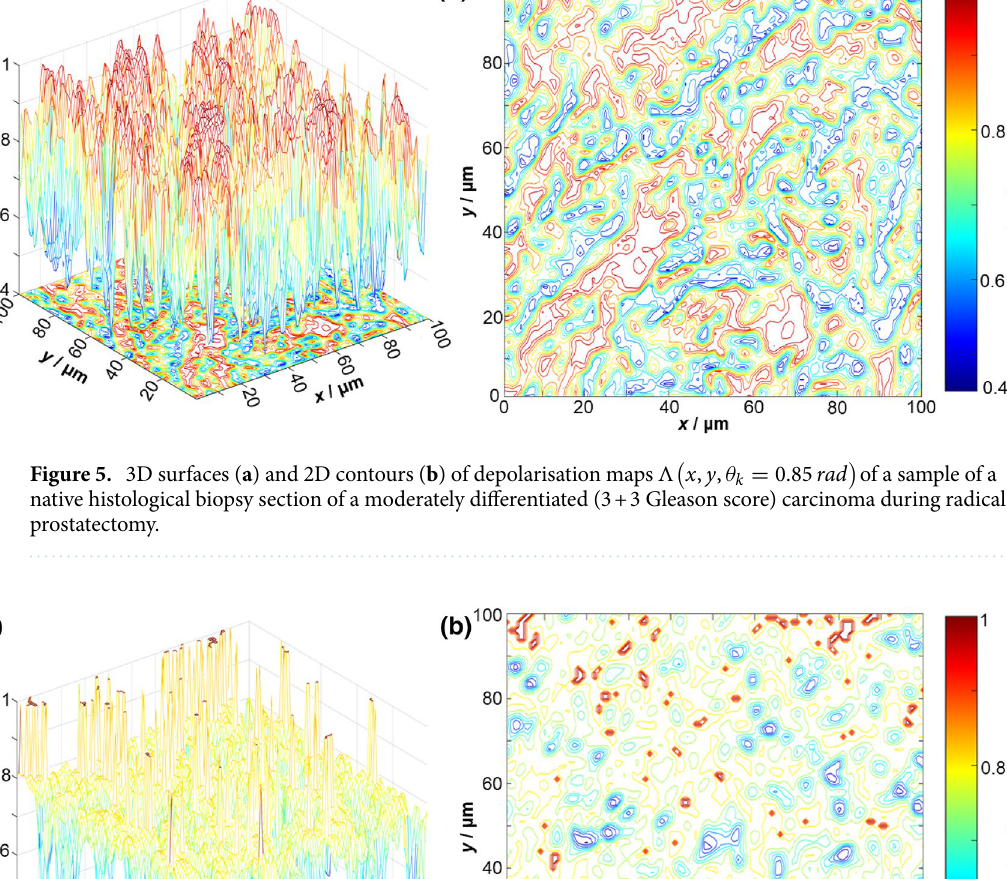
Figure 6. 3D surfaces ( a ) and 2D contours ( b ) of depolarisation maps � a native histological biopsy section of a poorly differentiated (4 + 4 Gleason score) carcinoma during radical prostatectomy.